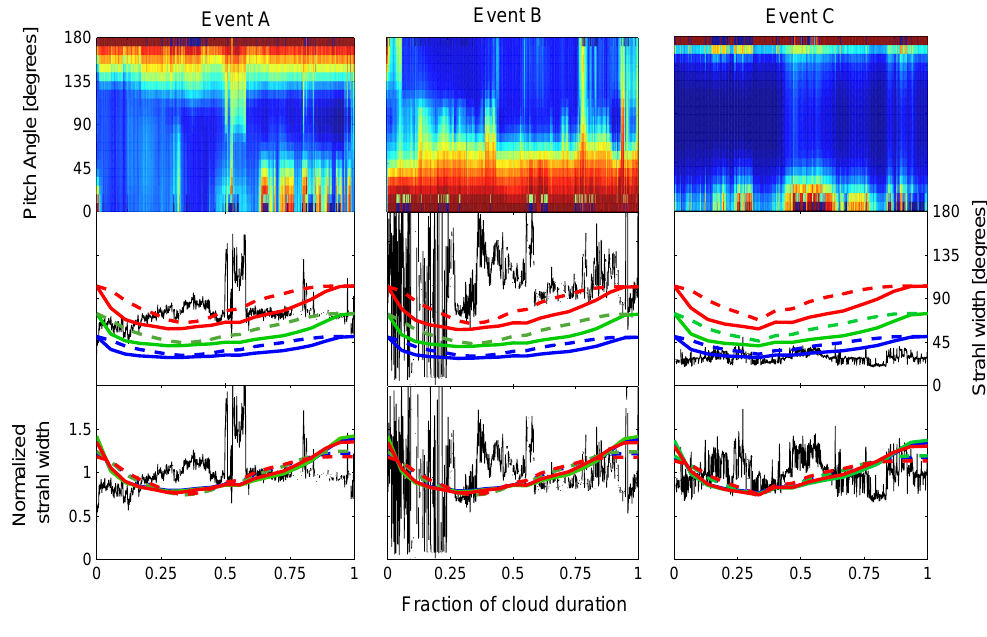
Fig. 7. The suprathermal electron properties inside the three magnetic cloud case studies. The top panels show the normalized pitch-angle distribution within the clouds. The black lines in the middle panels show the widths of the dominant strahls, computed from a Gaussian fit in pitch-angle space, with the colored lines showing the expected strahl width variations for different flux rope encounters (in the same format as Fig. 4). The bottom panels show the normalized strahl widths in the same format.